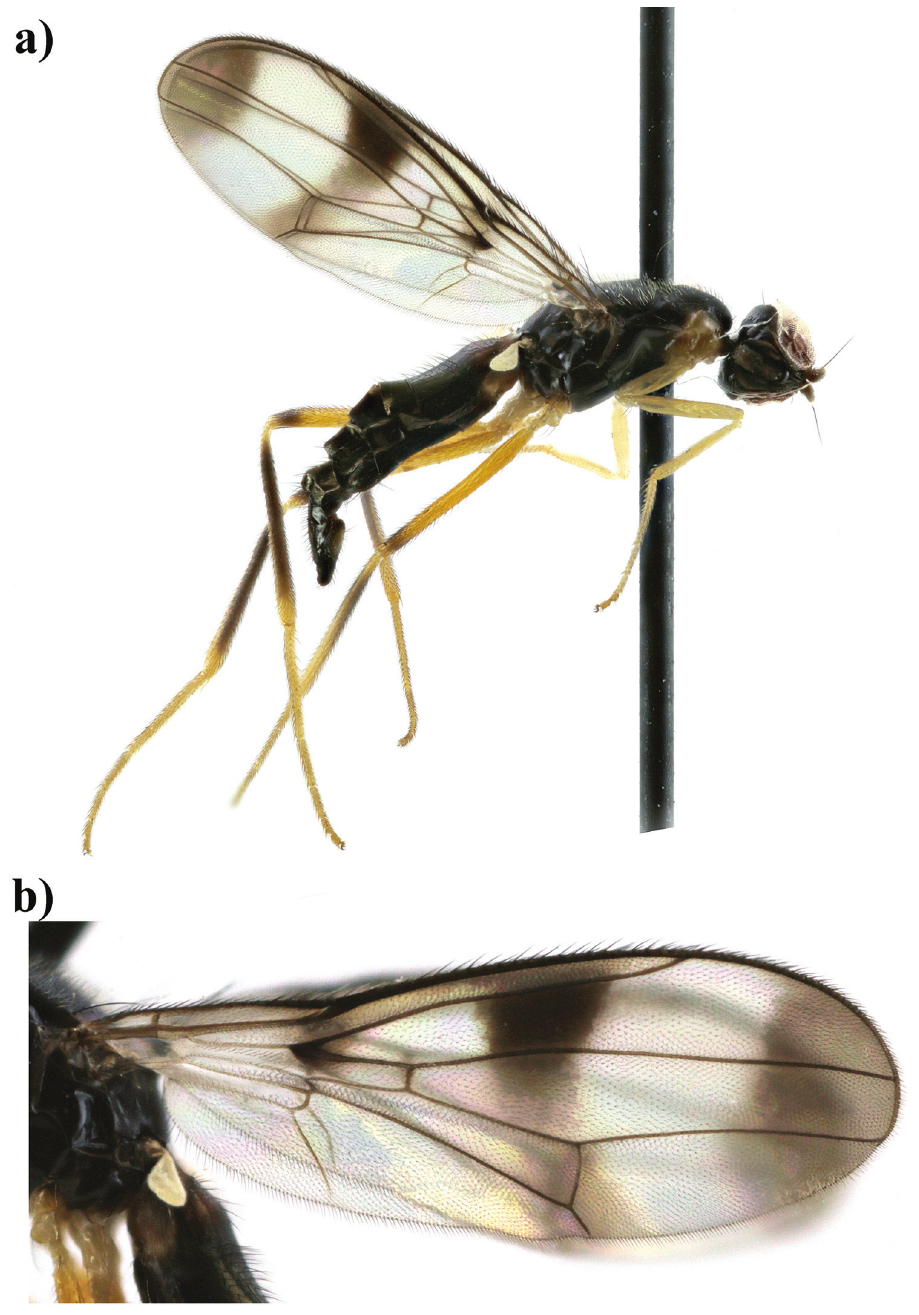
Figure 1. Strongylophthalmyia annulipes sp. n. a habitus, lateral view b